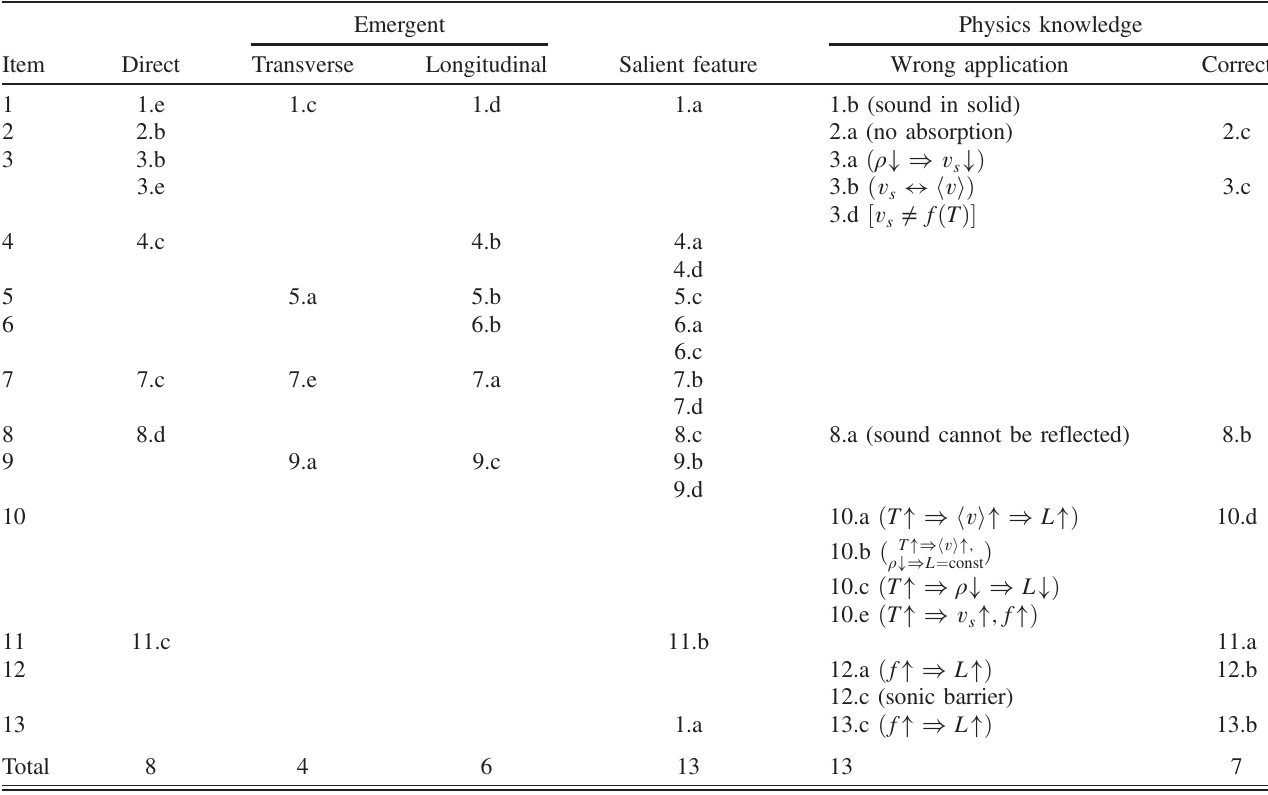
TABLE II. Categories of distractors. Here v s is the velocity of sound, L is loudness, ρ is density, f is frequency, T is temperature, D is the diameter of a speaking tube, and h v s i is the average thermal velocity of air